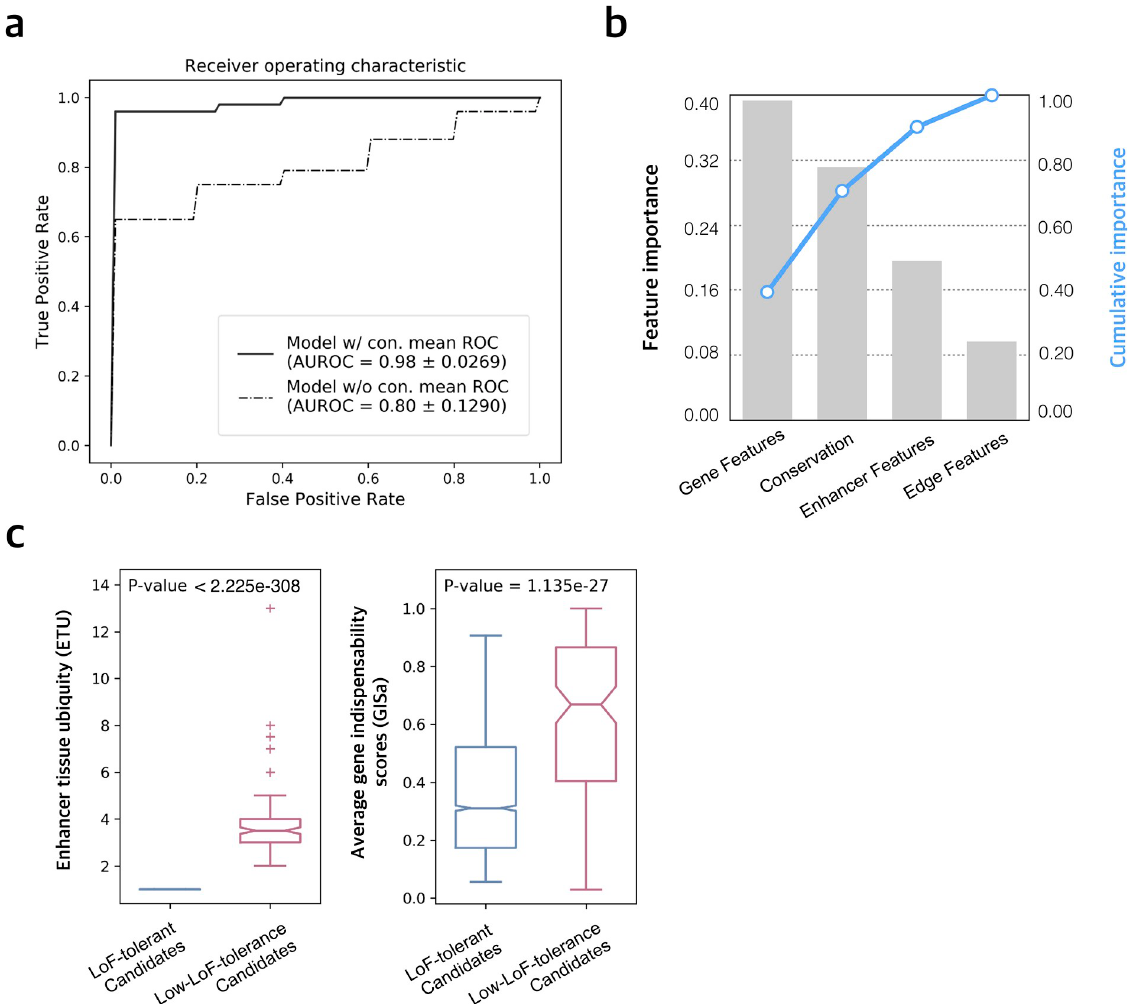
Fig 3. Model performance. a) Stratified 10-fold cross validation mean ROC of the final random forest classification model. Results shown with conservation included and excluded in the feature set. b) Collective feature importance for the classification model. X-axis shows the feature collections. Gene features include gene indispensability scores (GISa/v), and their centrality metrics in the MegaNet (GPRC, GDC, GID, GCC, GEC) and gene in-degrees from each tissue subnetwork. Enhancer features include ETU, EOD in the MegaNet as well as EOD in each tissue subnetwork. Edge features refers to EGTUa/v. See Table 1 for further details of network features. c) Enhancer tissue ubiquity (ETU) and average gene indispensability scores (GISa) for LoF-tolerant and low-LoF-tolerance enhancer candidates.